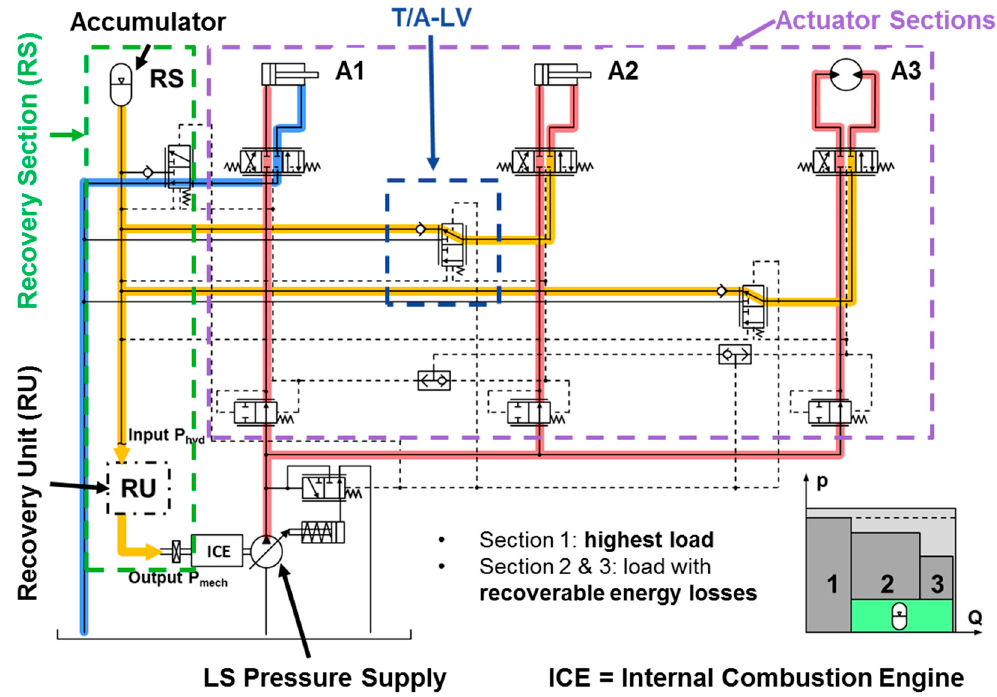
Figure 7. Load sensing system in optimized configuration. Previously disclosed in [15]. Reproduced with permission from the publisher.